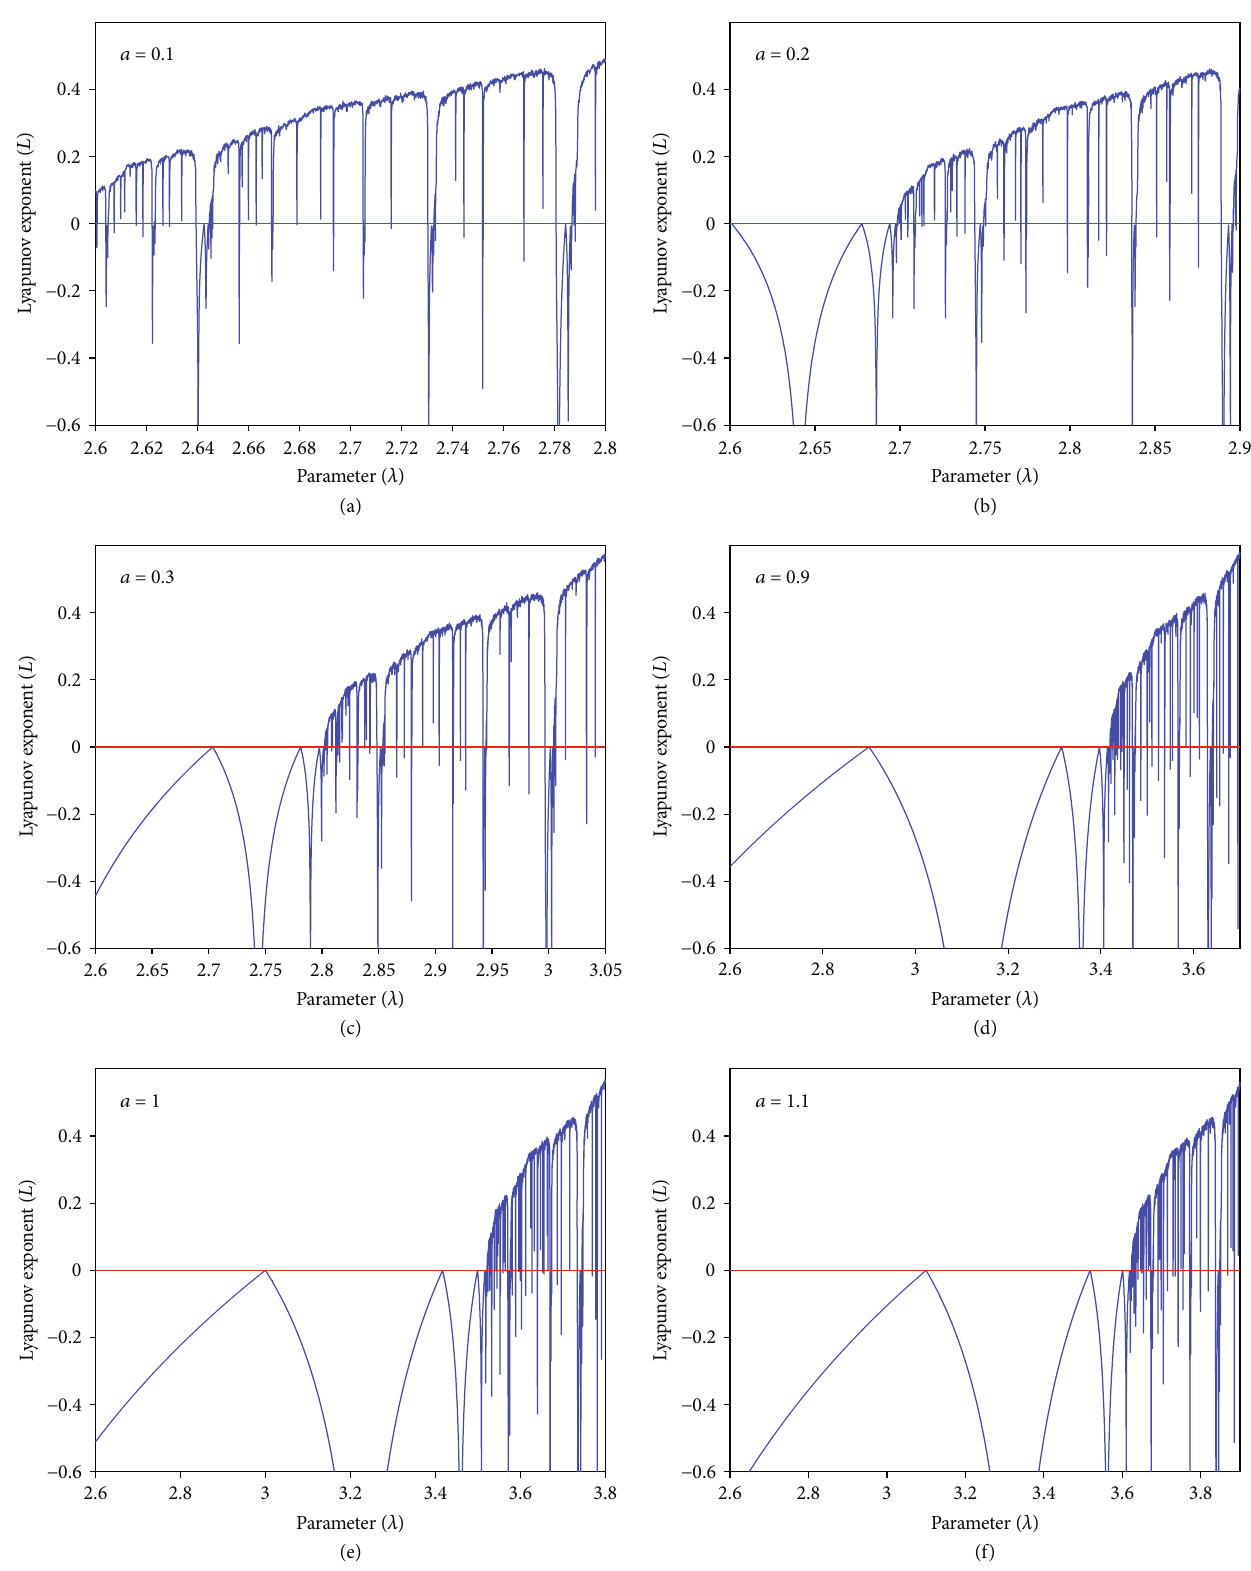
Figure 4: Lyapunov exponents for a = 0 : 1 , a = 0 : 2 , a = 0 : 3 , a = 0 : 9 , a = 1 , and a = 1 : 1